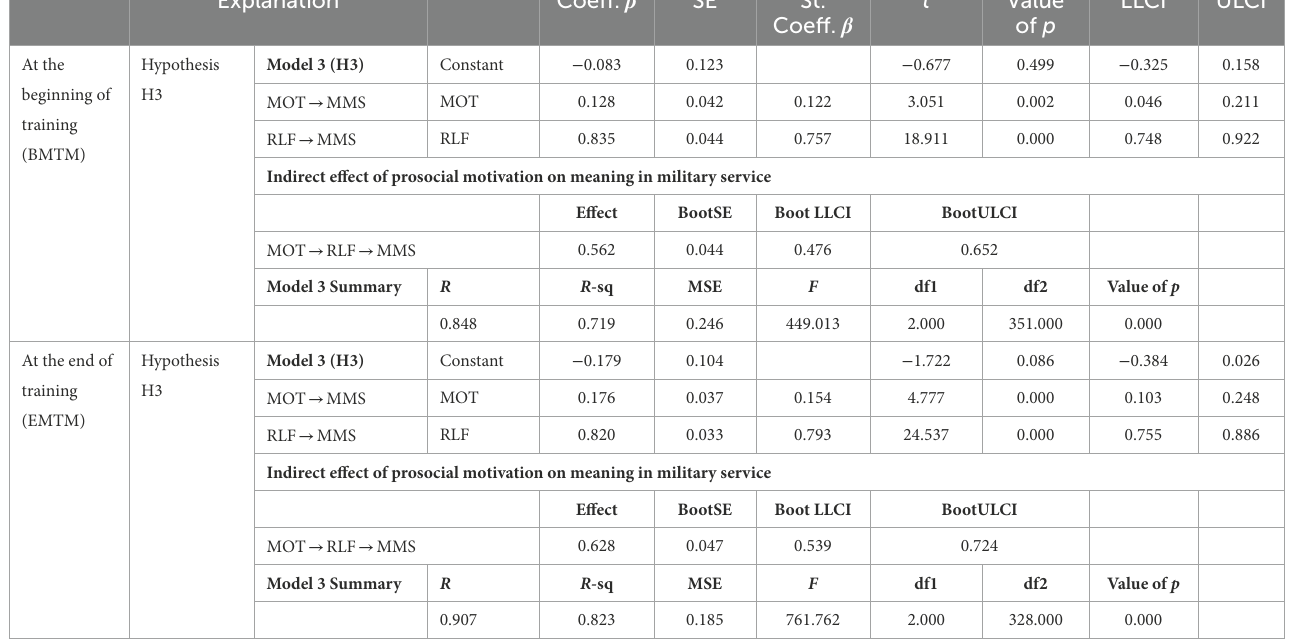
TABLE 5 The mediation effects of role fit evaluated by using the PROCESS v3.5 macro-Model 4. Explanation Coeff. β